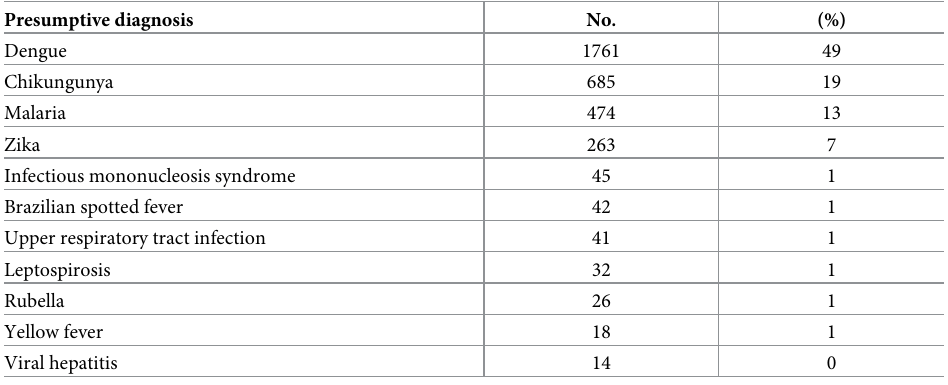
Table 2. Most frequent presumptive diagnosis after the first medical appointment (N = 3401). Presumptive diagnosis No. (%)